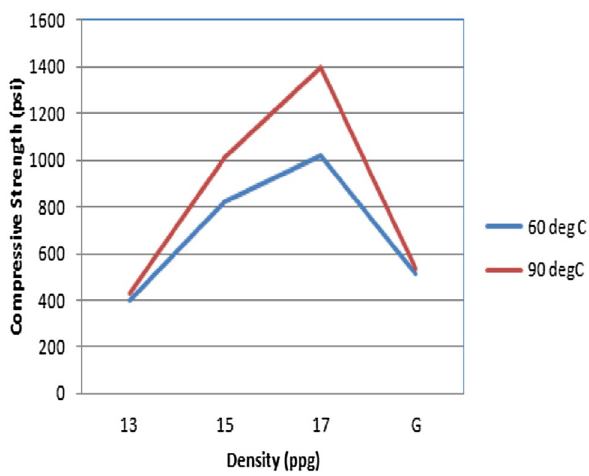
Fig. 1 Strength of geopolymer at 60 and 90 °C